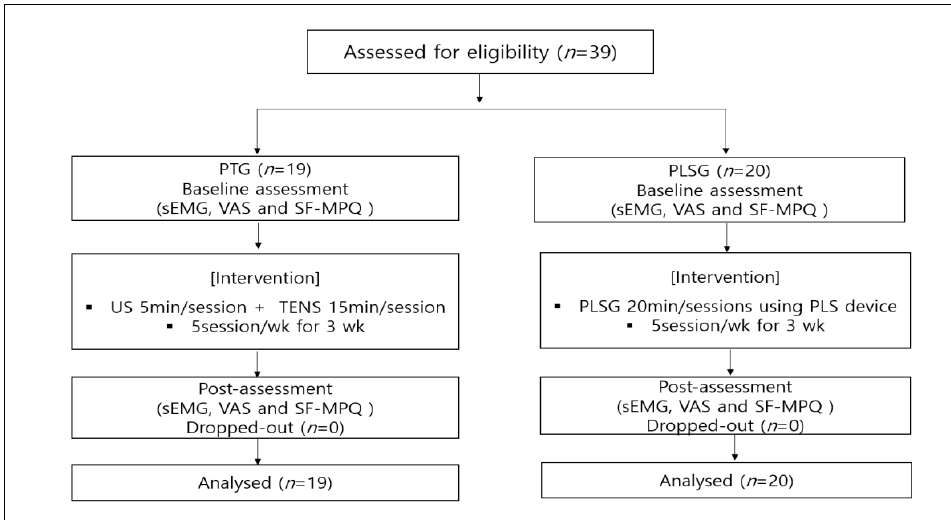
Figure 1. Flowchart of the general experimental design and number of participants in this clinical trial. PLS, personal low-frequency stimulation; PT, physical therapy; sEMG, surface electromyography; SF-MPQ, short-form McGill questionnaire; TENS, transcutaneous electrical nerve stimulation; US, ultrasound; VAS, visual analogue scale.